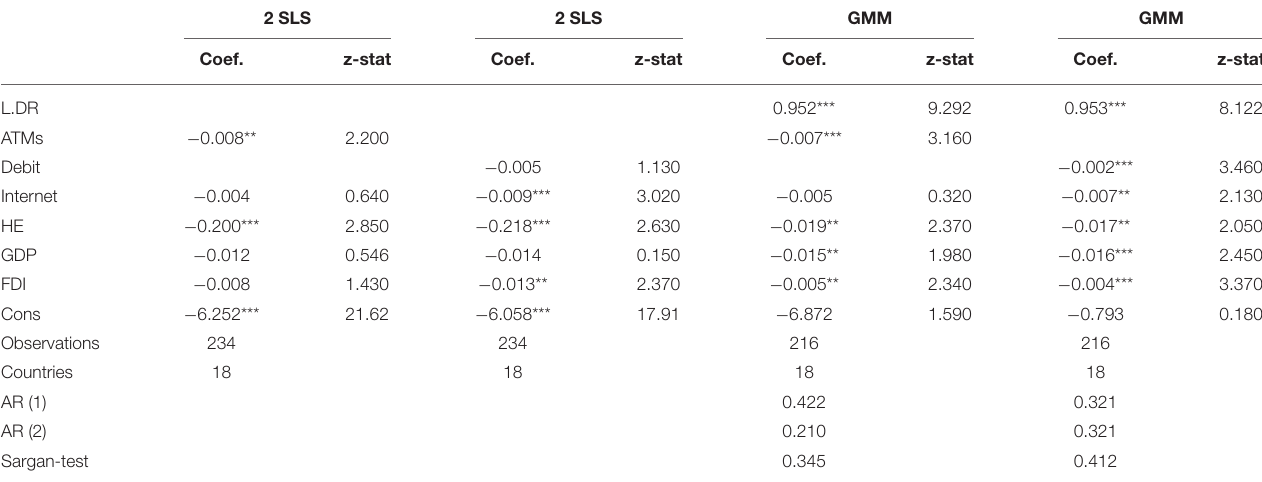
TABLE 5 | Financial inclusion and death rate (2 SLS &